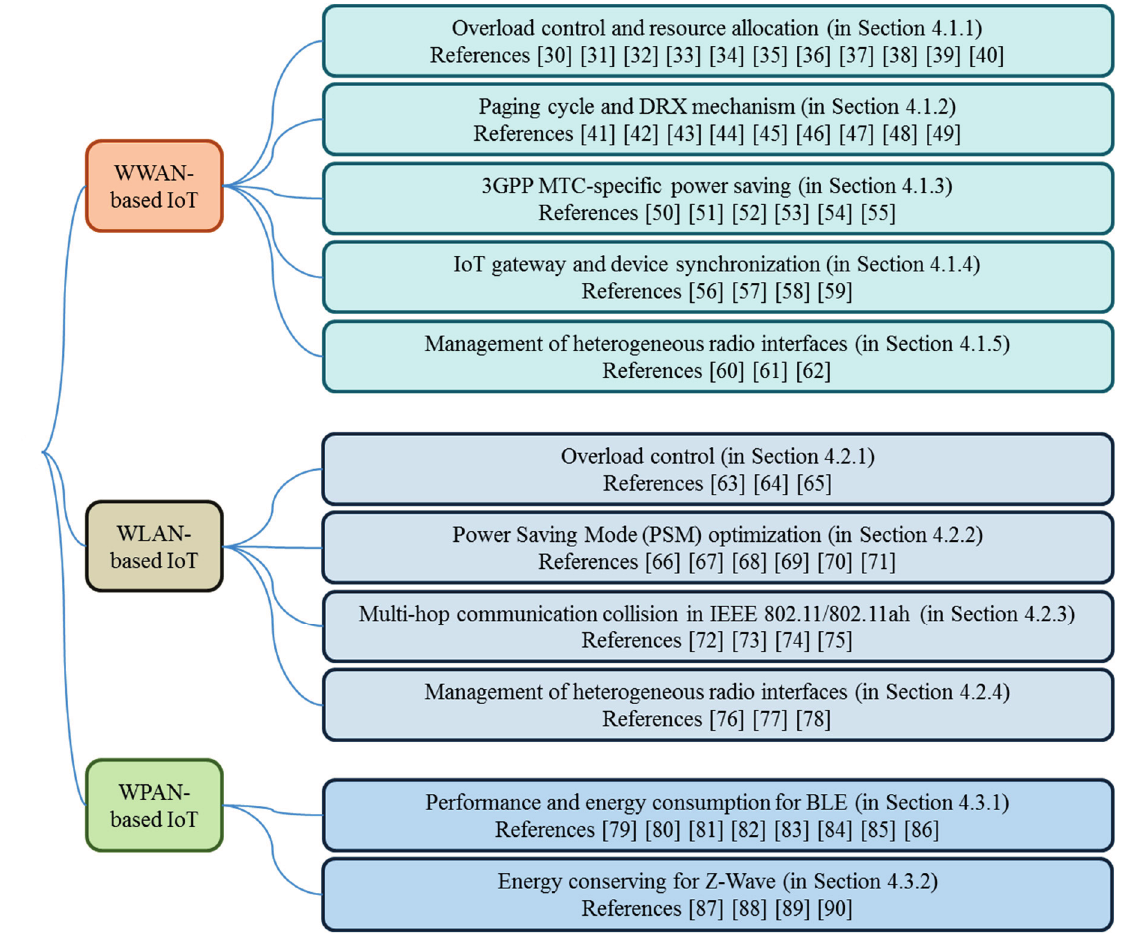
Figure 3. A taxonomy of IoT energy conserving issues for different types of radio access